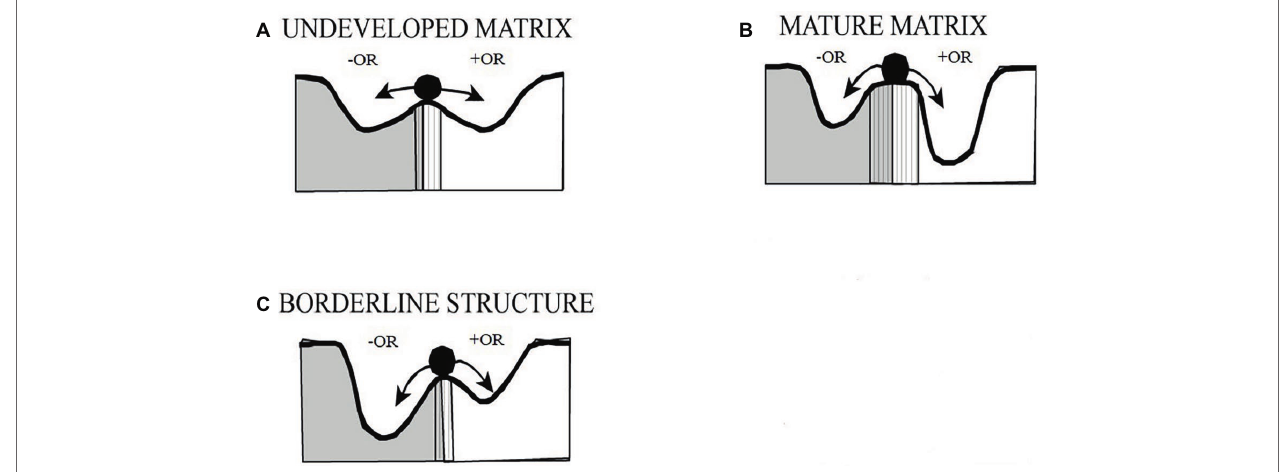
FIGURE 3 | Borderline dynamics of affectively organized object representation (OR), modified from Tretter and Lo¨ffler-Stastka, 2018, p. 11, with permission from the original author and copyright holder, Thieme Publishing. These figures show basins of attraction for positive and negative affect for typical early development (A) , typical mature development (B) , and dynamics of Borderline structure (C)